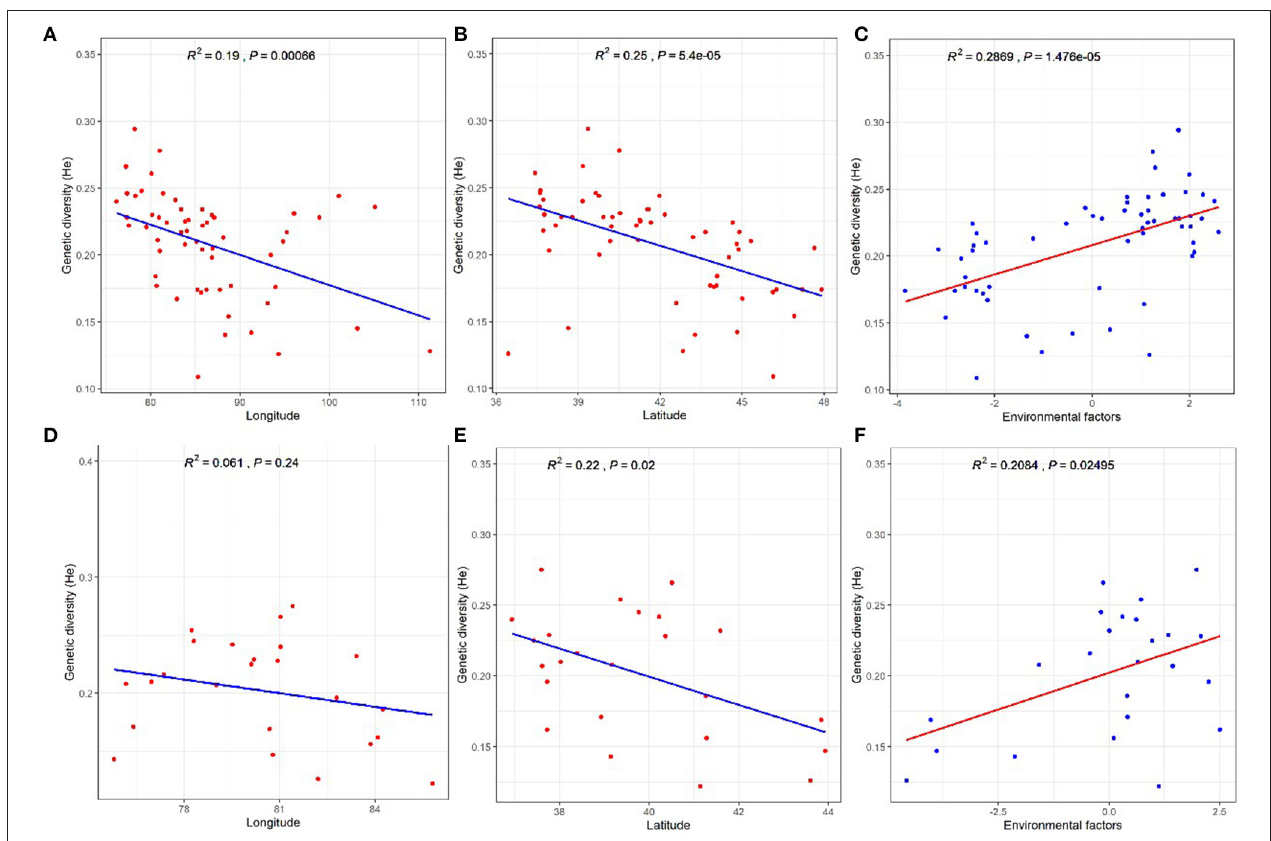
FIGURE 6 | Effects of geographical and environmental factors on genetic diversity in Populus populations. (A–C) P. euphratica . (D–F) P. pruinosa